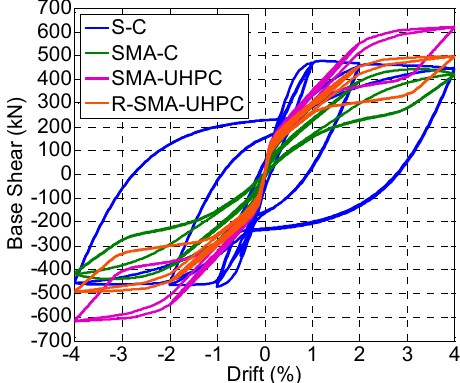
Figure 7. Base shear versus drift diagrams of the columns.